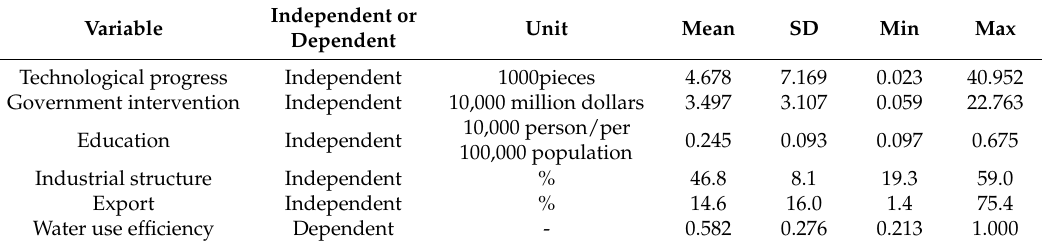
Table 3. Variables’ descriptive